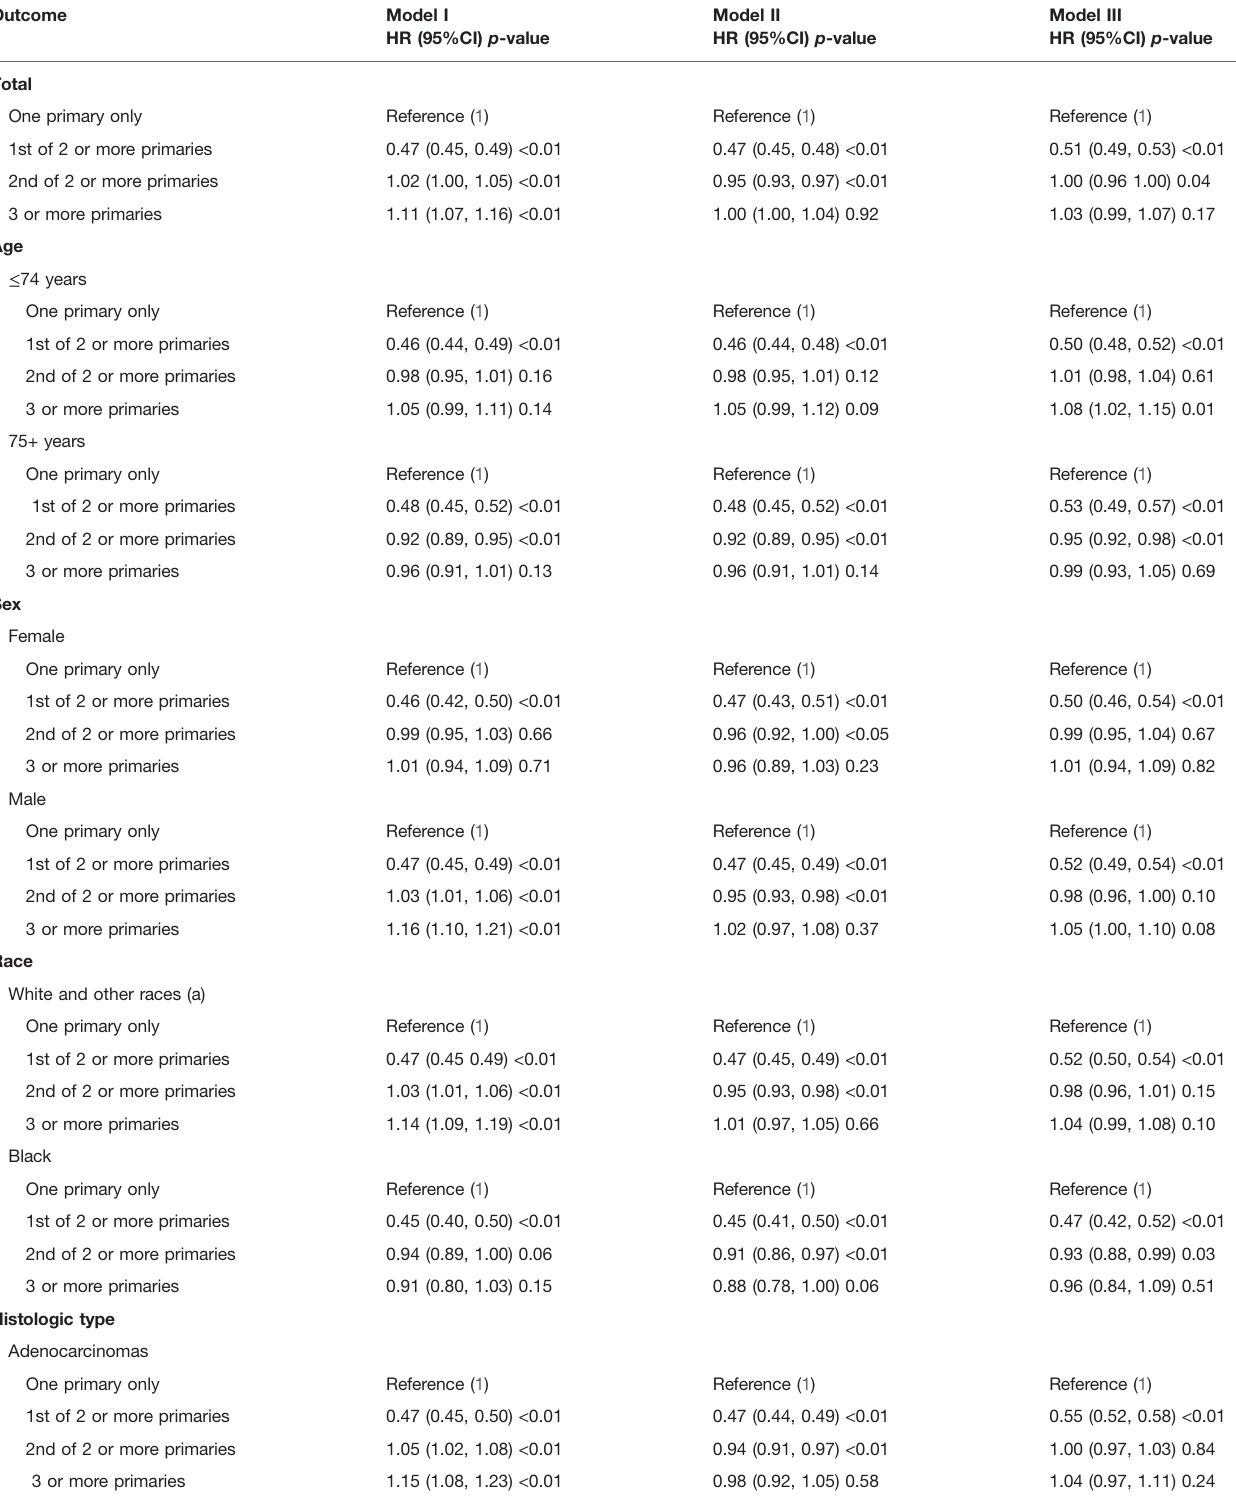
TABLE 5 | Cox multiple regression equation analysis in different models of adjustment (total analysis and strati fi ed